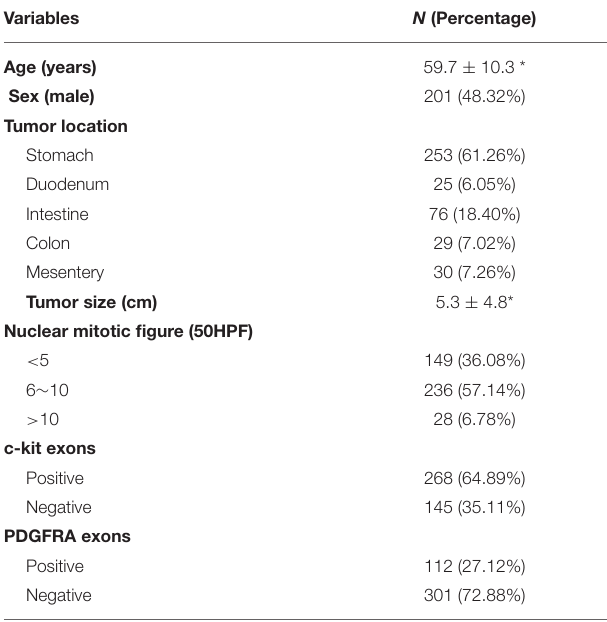
TABLE 1 | Patient baseline demographic and clinical characteristics at